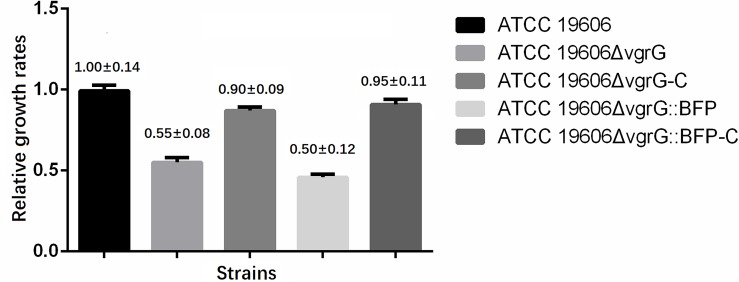
Effect of vgrG mutations on bacterial growth rates.Bacterial cells were dispensed into a 96-well microtiter plate and incubated at 37°C with shaking for 24 h. The growth rate of the mutant strain (A. baumannii ATCC 19606ΔvgrG) decreased remarkably compared to the parental strain.